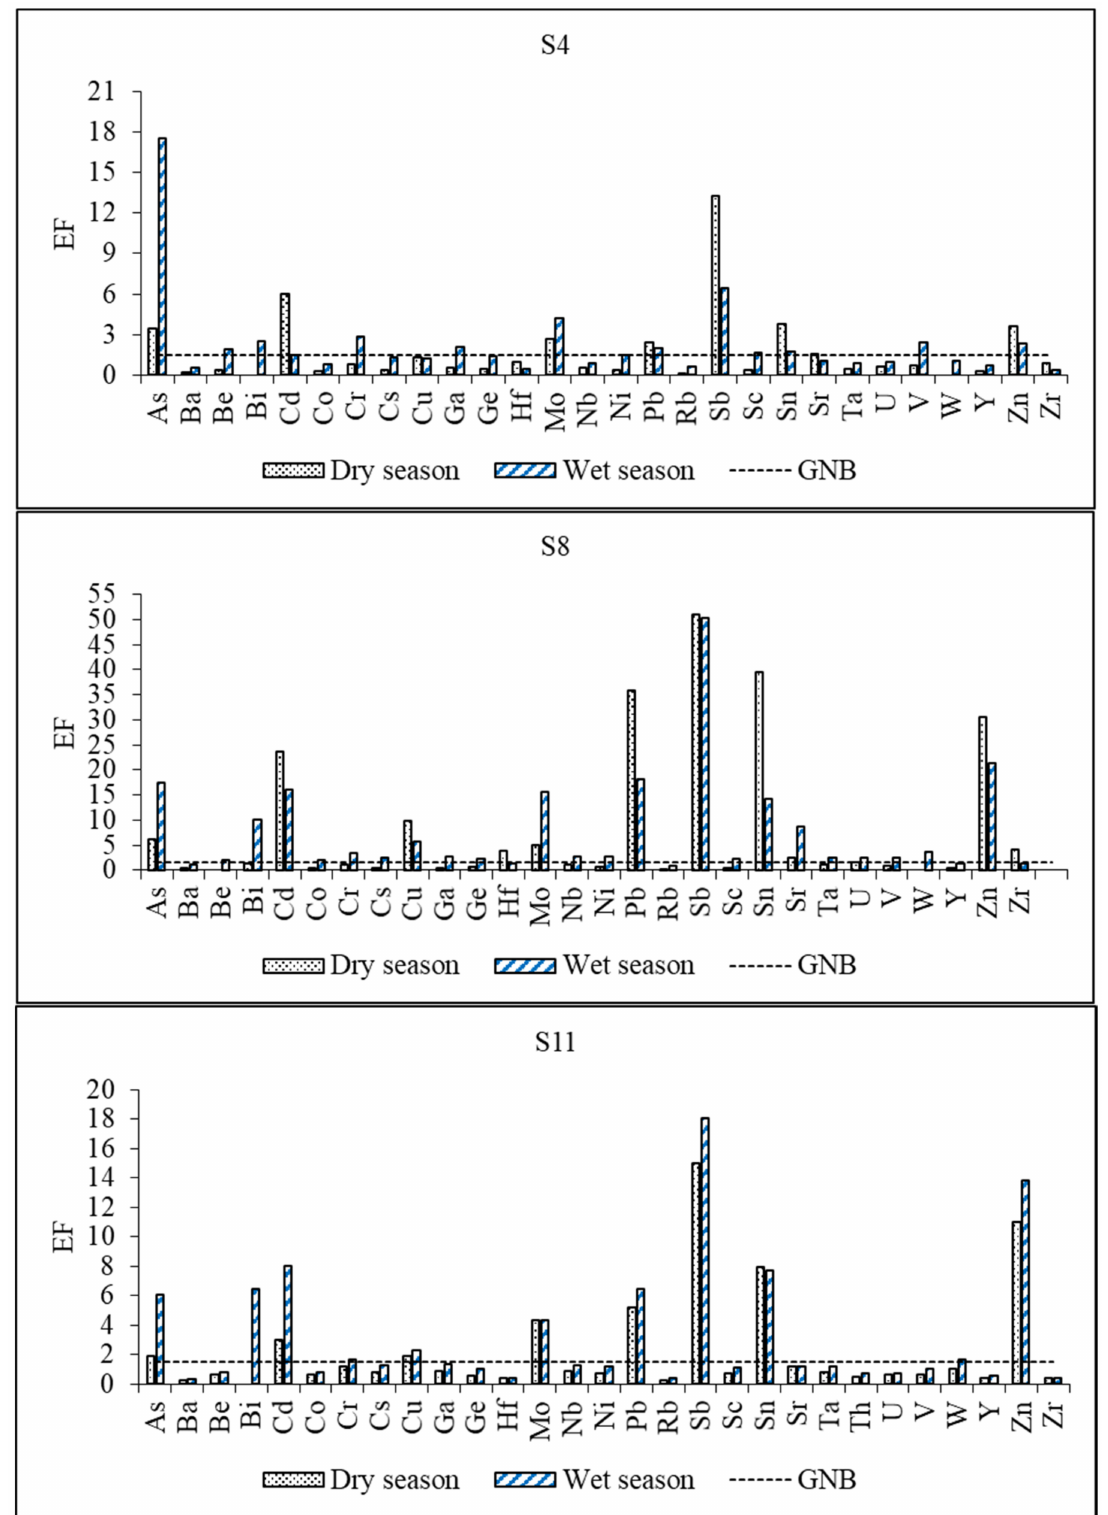
Figure 9. Distribution of TE enrichment factors (EF) for three sites (S4, S8, and S11) representative of each Lake (respectively Lake B è , East Lake, and West Lake). EF are calculated with Al as a normalizing element (as an example, but Cs and Ti give, more or less, the same patterns) and using Sed_R as local reference material. The dashed lines represent the geochemical natural background (GNB). EF values < 1.5 are within the range of the natural regional geochemical